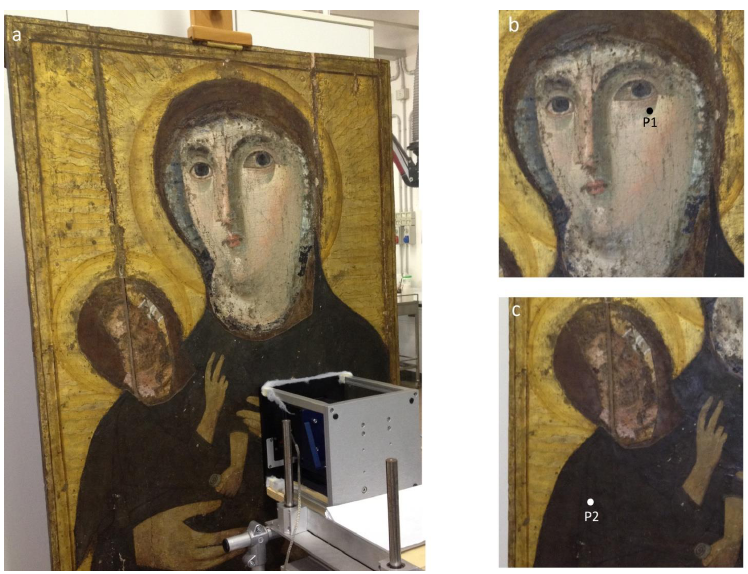
Figure 11. ( a ) Single-sided NMR collecting a stratigraphy of the Madonna Hodigitria icon. ( b , c ) Details of two regions of the icon measured by NMR. Adapted from [19].